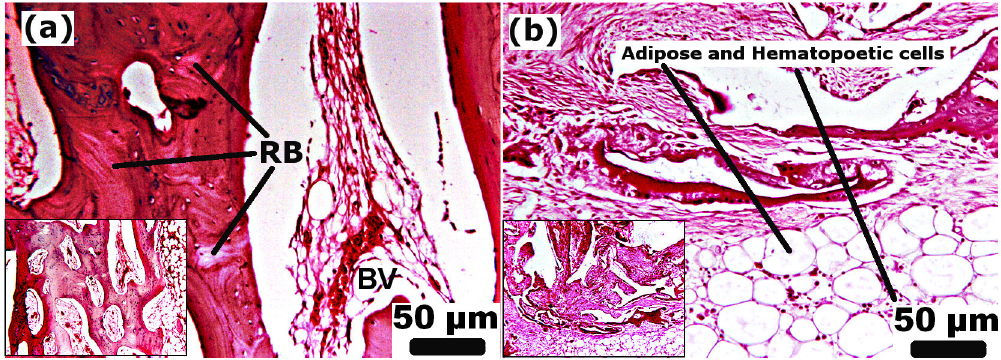
Figure 9. Histology illustrating hematoxylin and eosin (H&E) stained section of (a) n-HA/gel/CMC treated site and (b) SHAM after week 25 respectively. Defect site was covered by mature bone (osteocytes in lacunae) with blood vessel indicated complete remodeling. BV: blood vessels, RB: remodeled bone. Scale Bar: 50µm (magnification=125X, inset magnification=50X).